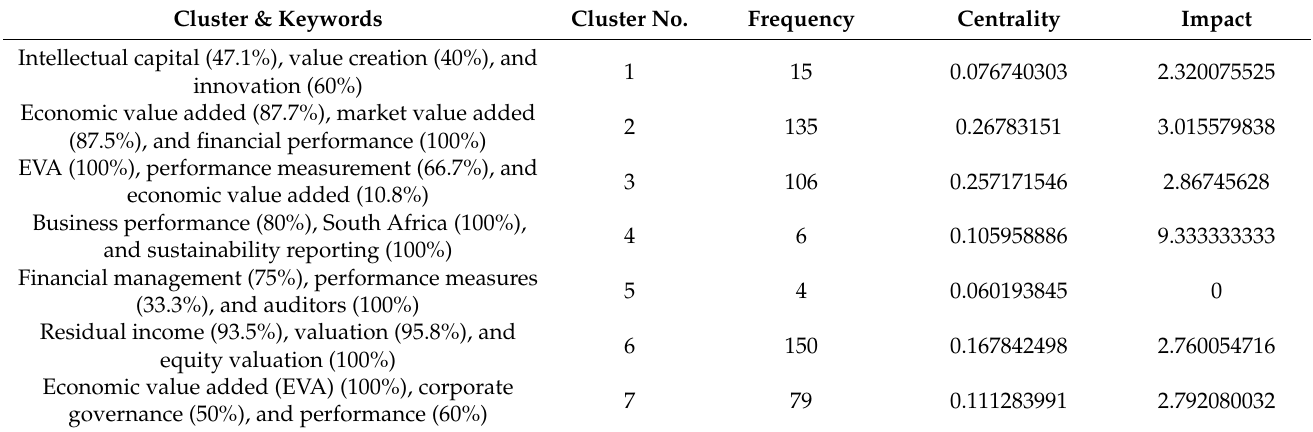
Table 5. Results of Bibliographic Coupling Summarizing Description of Knowledge